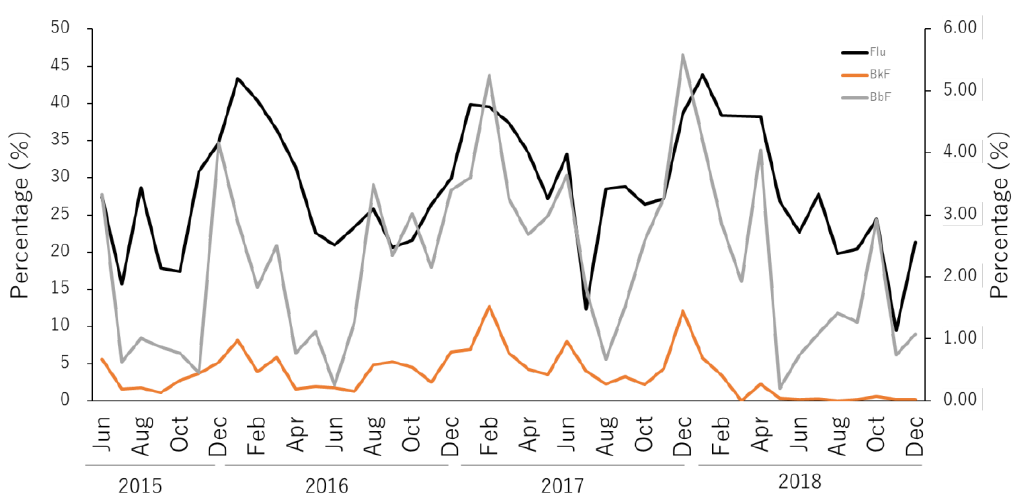
Figure5. Seasonalchangeofrelativeabundanceoffluoranthene(principaly-axis), benzo[b]fluoranthene Figure 5. Seasonal change of relative abundance of fluoranthene (principal y-axis), (secondary y-axis) and benzo[k]fluoranthene (secondary y-axis) in the dissolved phase in North Nanao benzo[b]fluoranthene (secondary y-axis) and benzo[k]fluoranthene (secondary y-axis) in the Bay during dissolved phase in North Nanao Bay during 2015–2018.